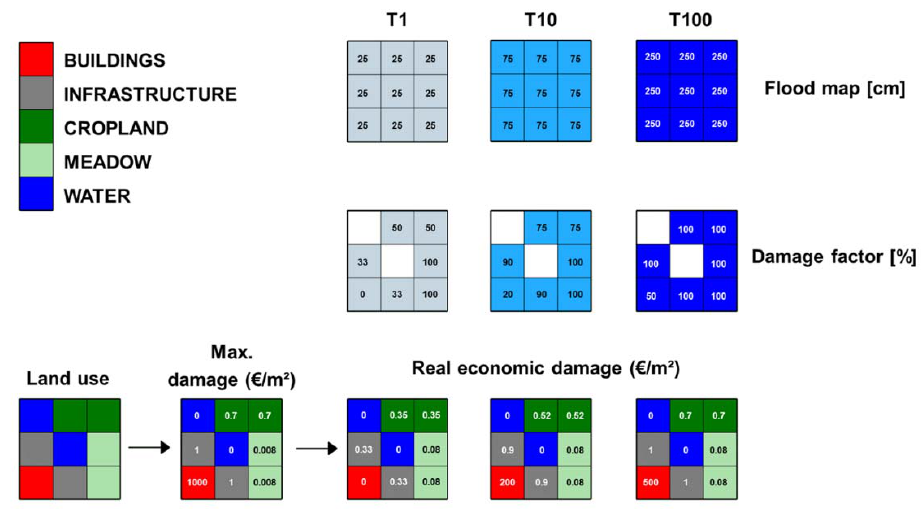
Figure 1. The Standard Method visualized for the LATIS flood impact analysis in Flanders, Belgium (adapted from [15]).